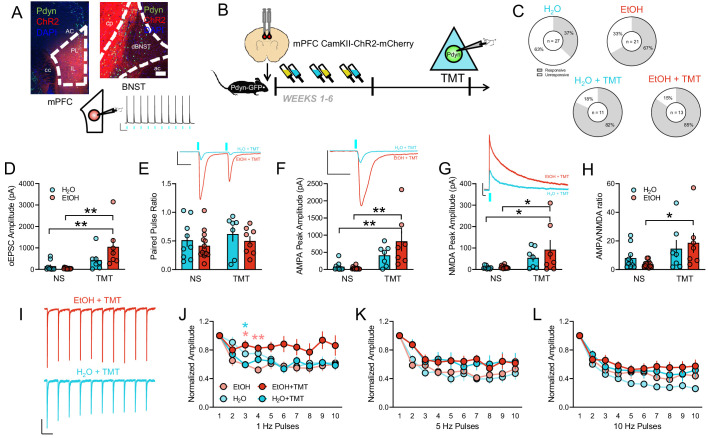
Cortical input onto BNSTPDYN cells gates stress-enhanced glutamatergic plasticity after history of alcohol.(A) Image of CamKII-ChR2-mCherry expression in the mPFC (left) and at BNST terminals (right). Pdyn-GFP cells are green. Inset photo scale bars measure 100 µm. Representative traces of optically-evoked mPFC action potentials at 1 Hz. Blue rectangles indicate 470 nm LED onset. Scale bar indicates 20 mV and 1 s. (B) Experimental design testing synaptic connectivity of mPFC input to BNSTPDYN cells using channelrhodopsin (ChR2) after EtOH and TMT. (C) Proportions of light-responsive (white) and non-light-responsive (grey) BNSTPDYN cells to optically evoked EPSC in H2O (10/27 responsive cells, n = 7), EtOH (14/21 responsive cells, n = 5), H2O + TMT (9/11 responsive cells, n = 4), and EtOH + TMT (11/13 responsive cells, n = 4) groups. (D) mPFC-BNSTPDYN oEPSC amplitude (pA). (E) Paired pulse ratio. Inset example traces of H2O + TMT (aqua) and EtOH + TMT (red) with blue LED onset. Scale bar indicates 200 pA height and 50 ms time. (F) AMPA peak amplitude (pA). Inset AMPA traces of H2O + TMT (aqua) and EtOH + TMT (red) with blue LED onset. Scale bar indicates 200 pA height and 50 ms time. (G) NMDA peak amplitude (pA). Inset NMDA traces of H2O + TMT (aqua) and EtOH + TMT (red) with blue LED onset. Scale bar indicates 200 pA height and 50 ms time. (H) AMPA/NMDA ratio. (I) Representative traces of 1 Hz pulse trains in EtOH + TMT (red) and H2O + TMT (aqua) BNSTPDYN cells. Scale bar indicates 200 pA height and 1 s time. oEPSC normalized amplitude across (J) 1 Hz, (K) 5 Hz, and (L) 10 Hz pulse trains. *p<0.05. **p<0.01.